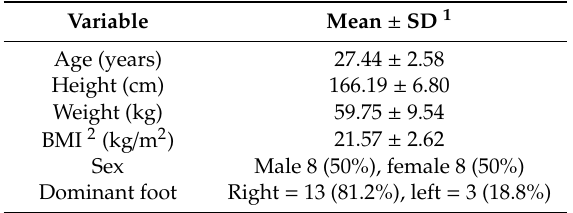
Table 1. Descriptive statistics of the study participants ( n =